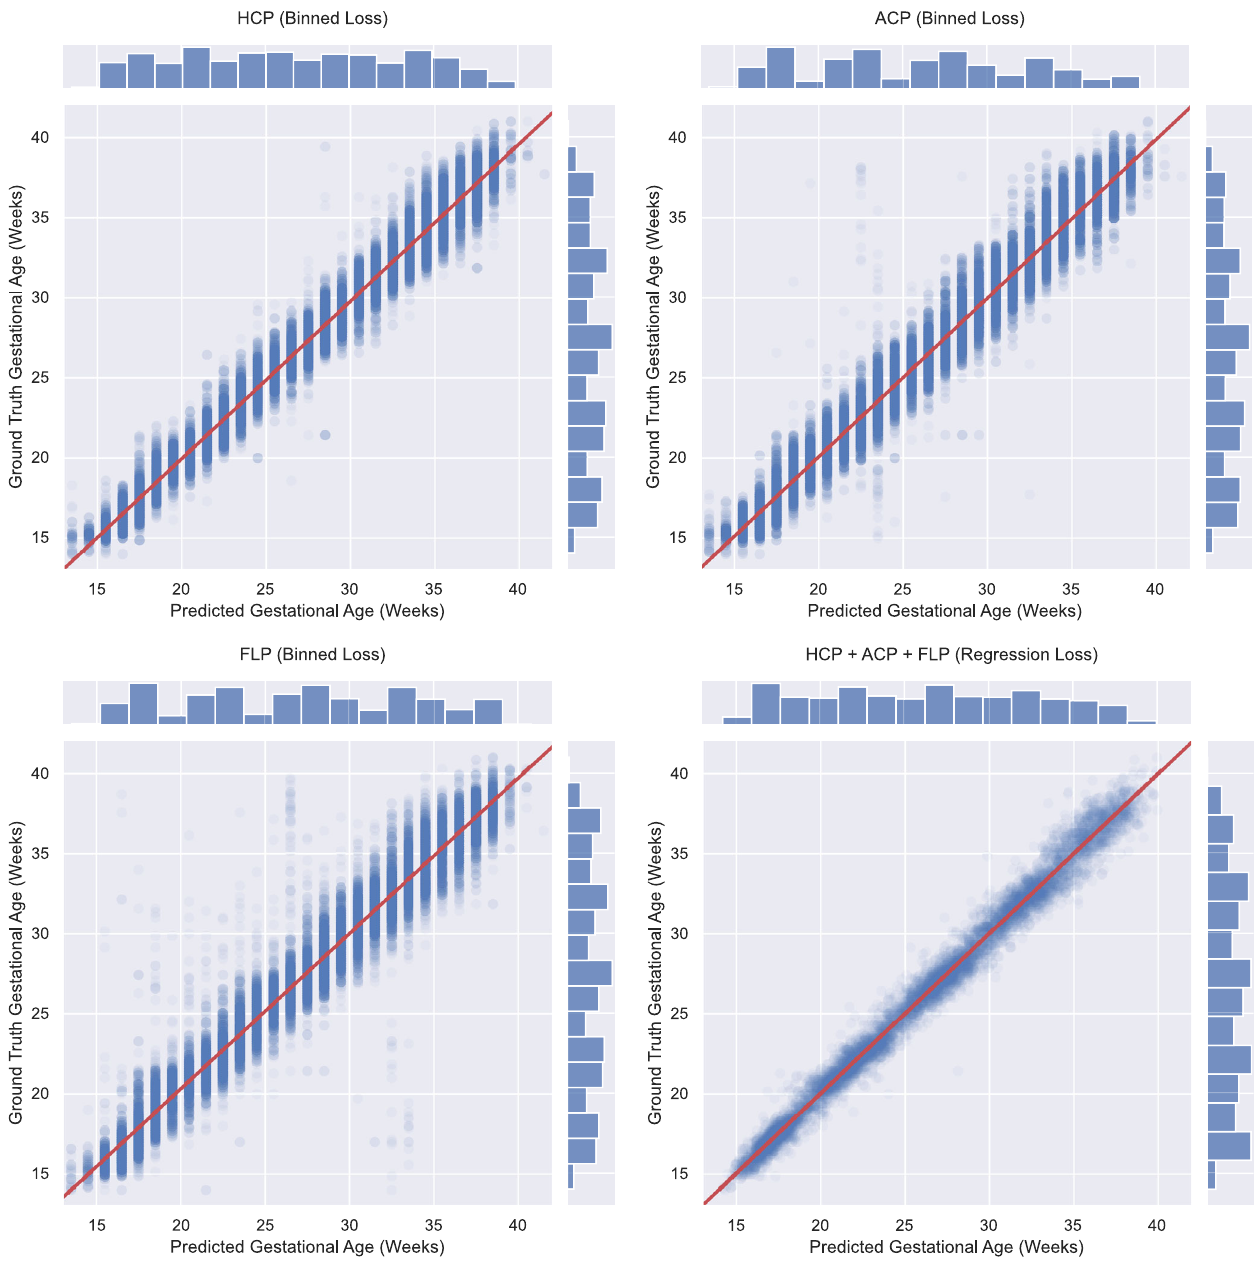
Fig. 2 Performance per plane and MultiPlane on the INTERBIO-21st external validation set. Composite fi gure showing scatter plot of the performance of the proposed single standard plane and MultiPlane models on the INTERBIO-21st test set with histograms showing the spread of planes across gestational ages. HCP Head Circumference Plane, ACP Abdominal Circumference Plane, FLP Femur Length